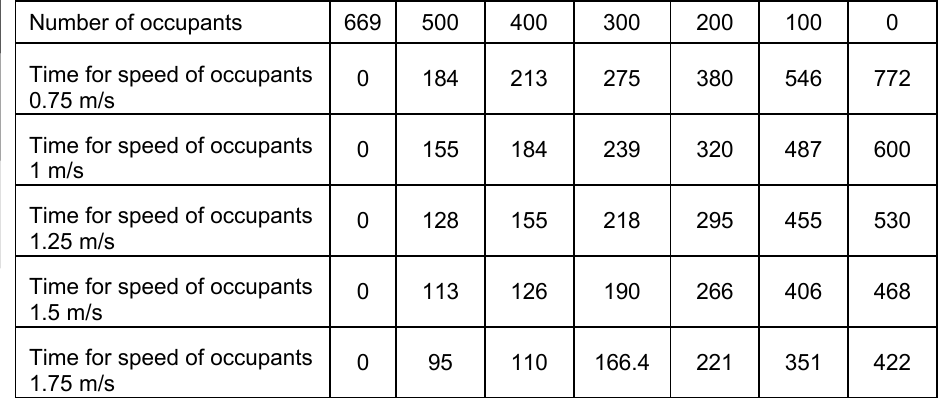
Table 5 – Simulation results in seconds for the second scenario, with elevators enabled and the third entrance/exit blocked and for the occupants’ speeds from 0.75 m/s, 1 m/s, 1.25 m/s, 1.5 m/s, and 1.75